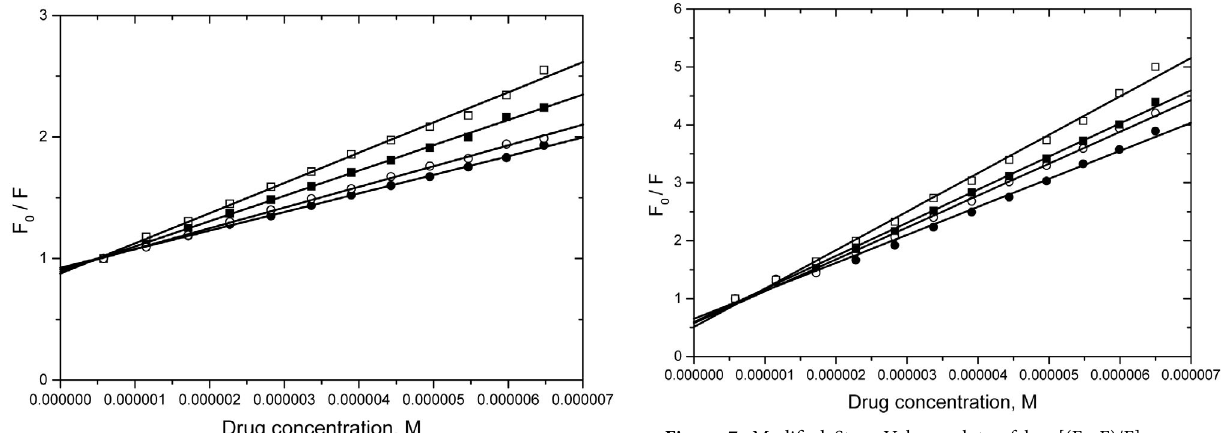
Figure 7. Modified Stern-Volmer plots of log [(F 0 –F)/F] versus log[drug] for nandrolone decanoate -ionic liquid-HSA system at different temperatures; the presence of [BMIM]BF4 or [BMIM]PF6, [HSA] = 2